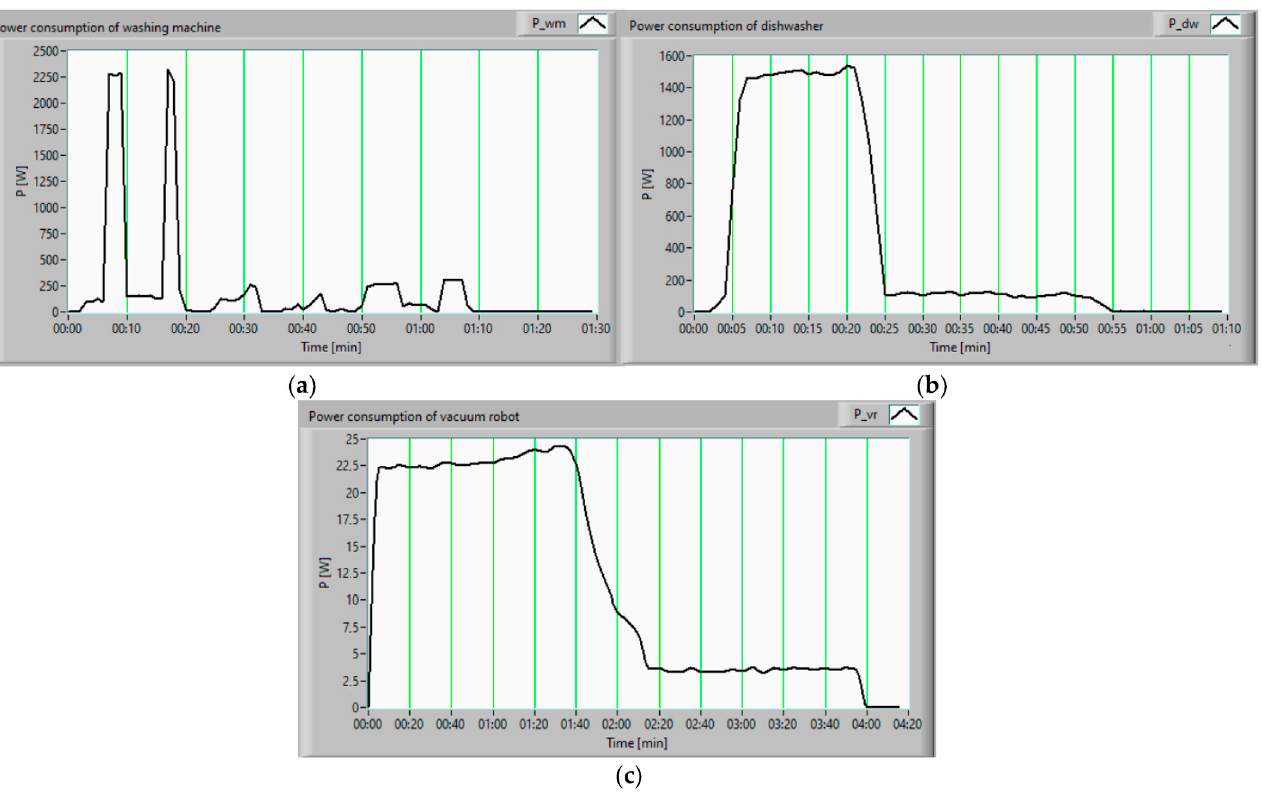
Figure 5. Energy load profiles of the ( a ) washing machine; ( b ) dishwasher; ( c ) vacuum